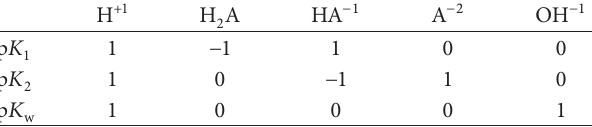
Table 1: Stoichiometric matrix for model 1. H +1 H A HA −1 A −2 OH −1 2 p K 1 − 1 1 0 0 1 0 − 1 0 p K 2 0 0 0 p 𝐾 w